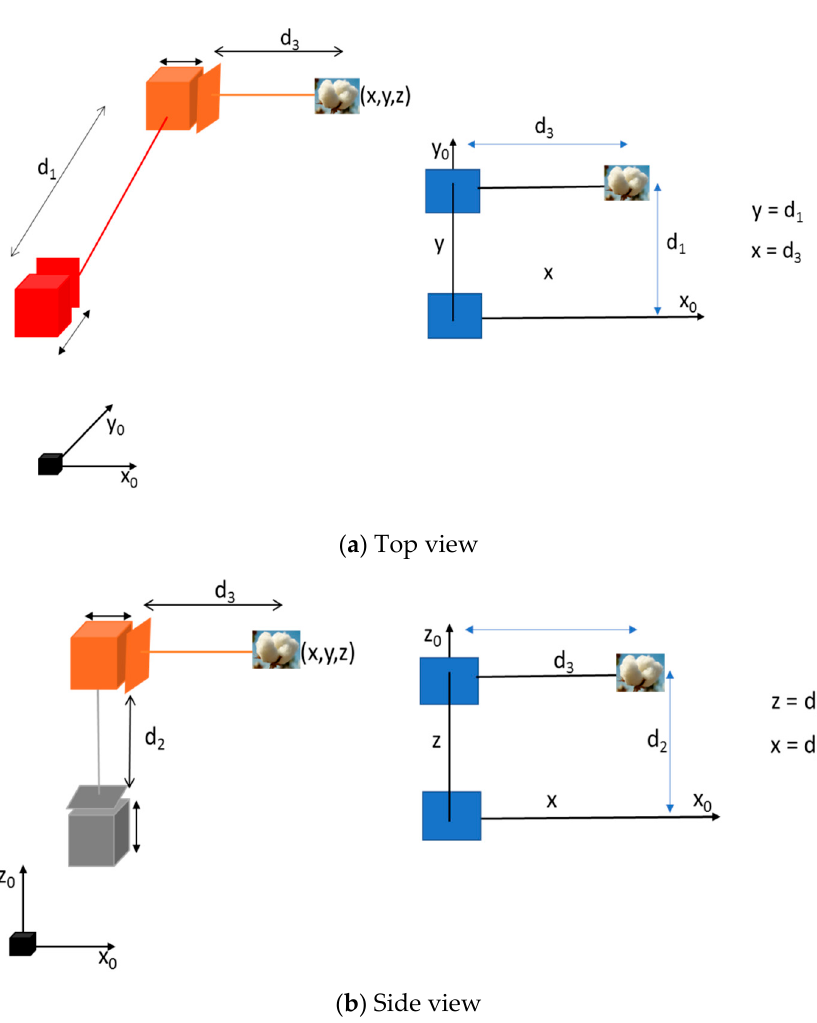
Figure 12. The inverse kinematics of the rover in detail (it is given by finding the distances d 1 , d 2 , and d 3 of the rover, using depth and coordinates of the boll ( x , y , z ) found by the ZED stereo camera).